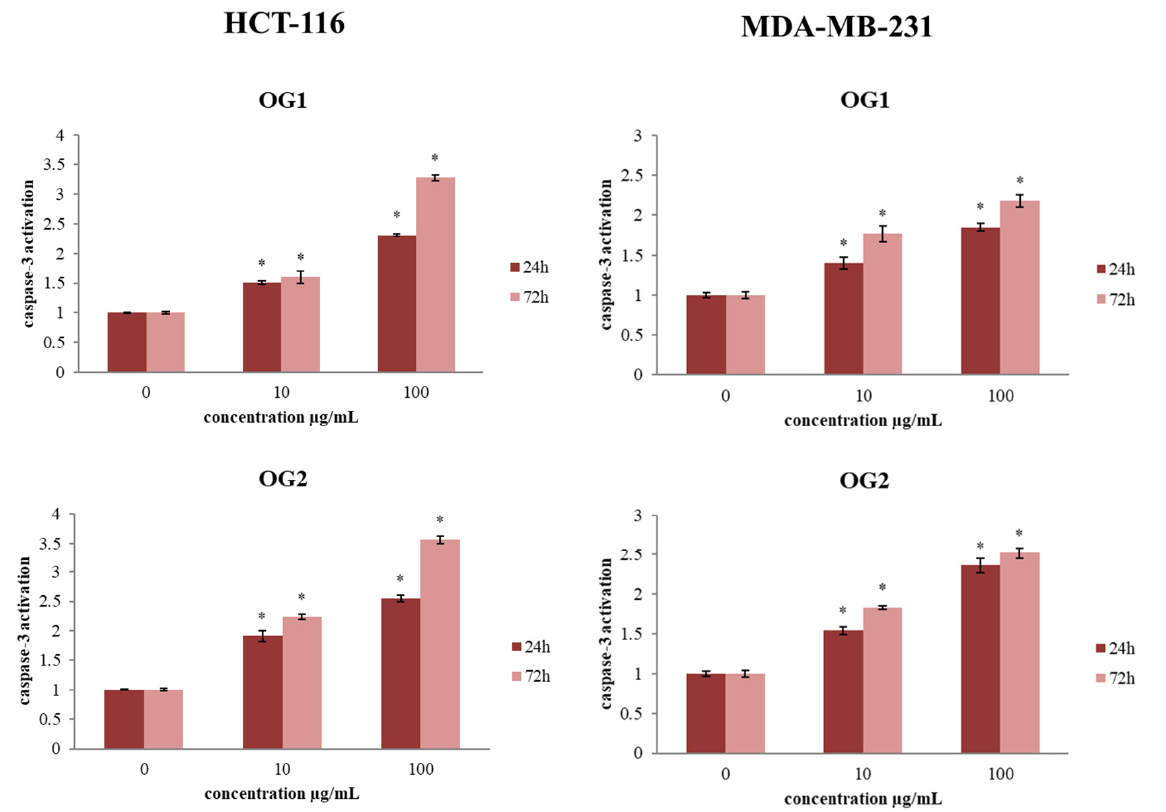
Figure 5. Antitumor activity of investigated essential oils against HCT-116 and MDA-MB-231 cells after 24 h and 72 h exposure with OG1 and OG2 oils at concentrations 10 µ g/mL and 100 µ g/mL compared to nontreated control cell. Caspase-3 activation was determined by using flow cytometry. Results are presented as the mean of three independent experiments ± standard error; * p < 0.05 relative to control.